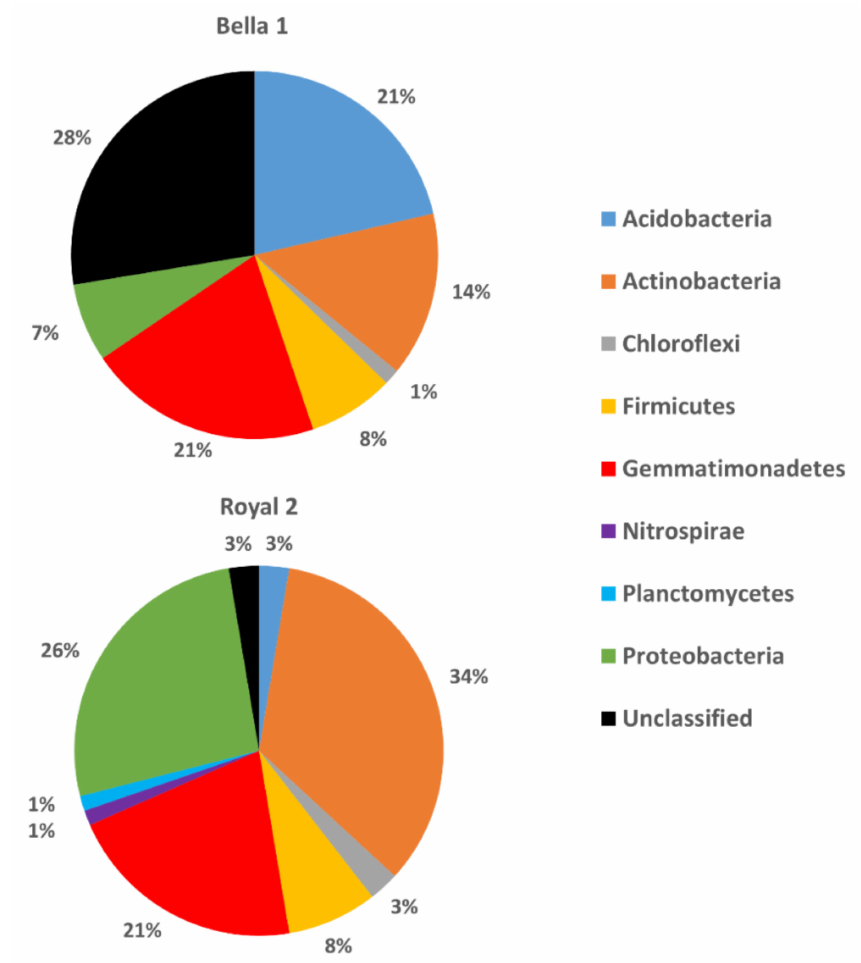
Figure 5. Distribution of bacterial phyla retrieved from Bella 1 and Royal 2